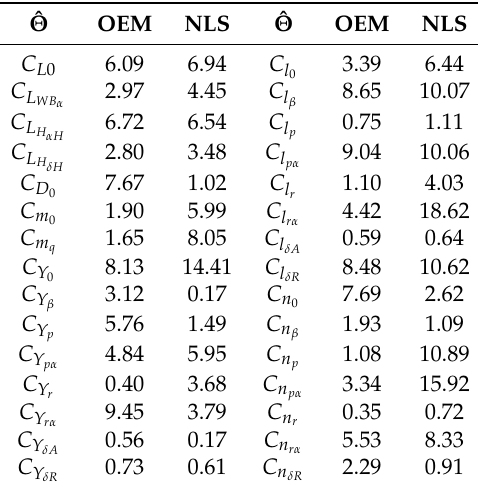
Table 2. Relative standard deviations,